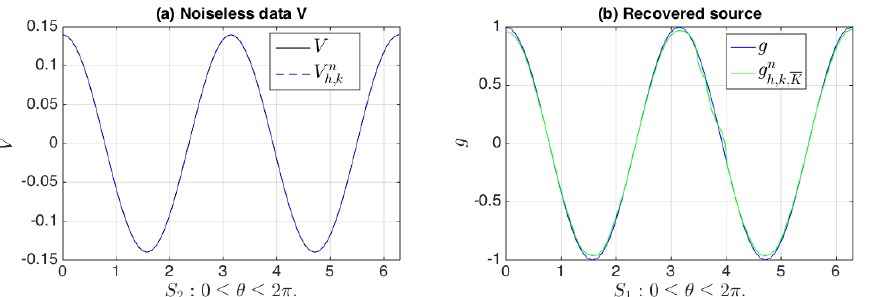
(blue). ( b ) Plots of exact source g Figure 2. ( a ) Plots of exact data V (black) and recovered data V n h , k (blue) and recovered source g n (green) on S 1 , corresponding to exact input data V , using mesh M 1 h , k , K of circular region Ω .